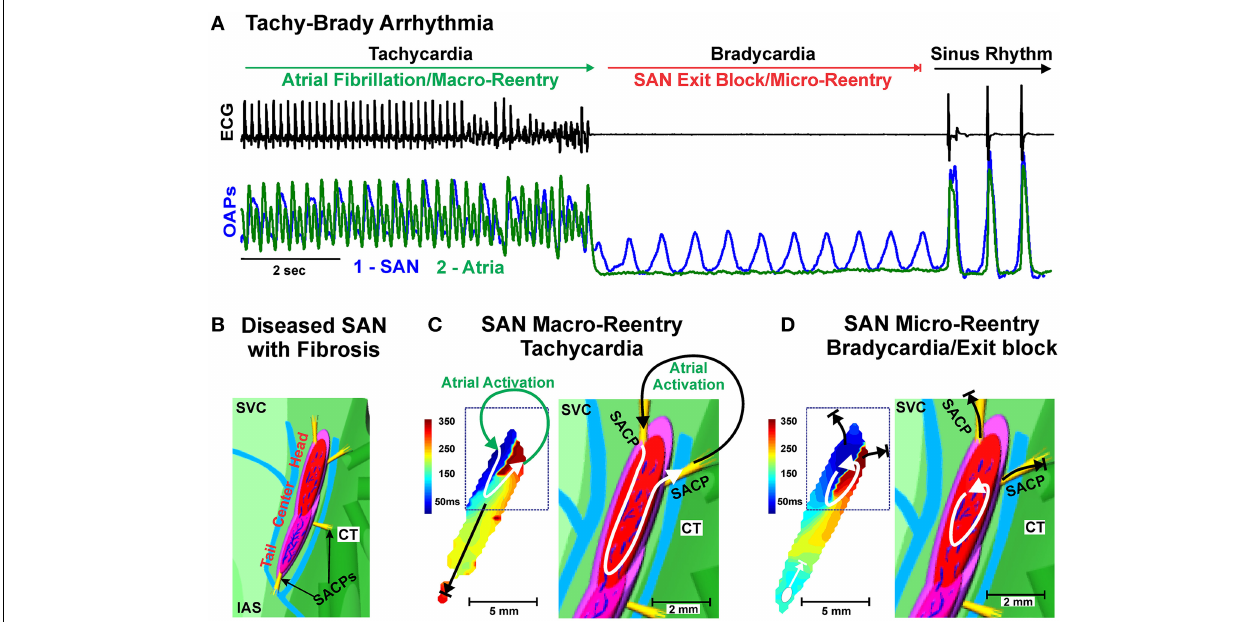
FIGURE 2 | (A) Example of Tachy-Brady arrhythmia often observed in structurally remodeled hearts with upregulated intranodal fibrosis. Atrial Fibrillation or Tachycardia leads to Bradycardia (long pauses) due to SAN exit block, followed by recovery of sinus rhythm or new Tachycardia event. ECG (black) and Optical Action Potentials (green and blue). Modified from Lou et al. (2013) with permission. (B) Enlarged epicardial view of 3D canine SAN model based on structural and functional data from optical mapping experiments. The SAN is demarcated from the atrium (green) by 3 bifurcating coronary arteries (light blue) and